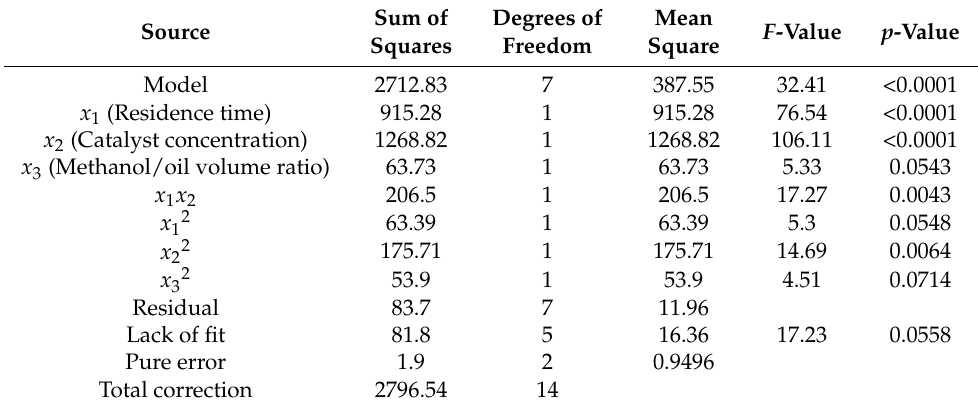
Table 3. Analysis of variance (ANOVA) assesment for the reduced quadratic model.